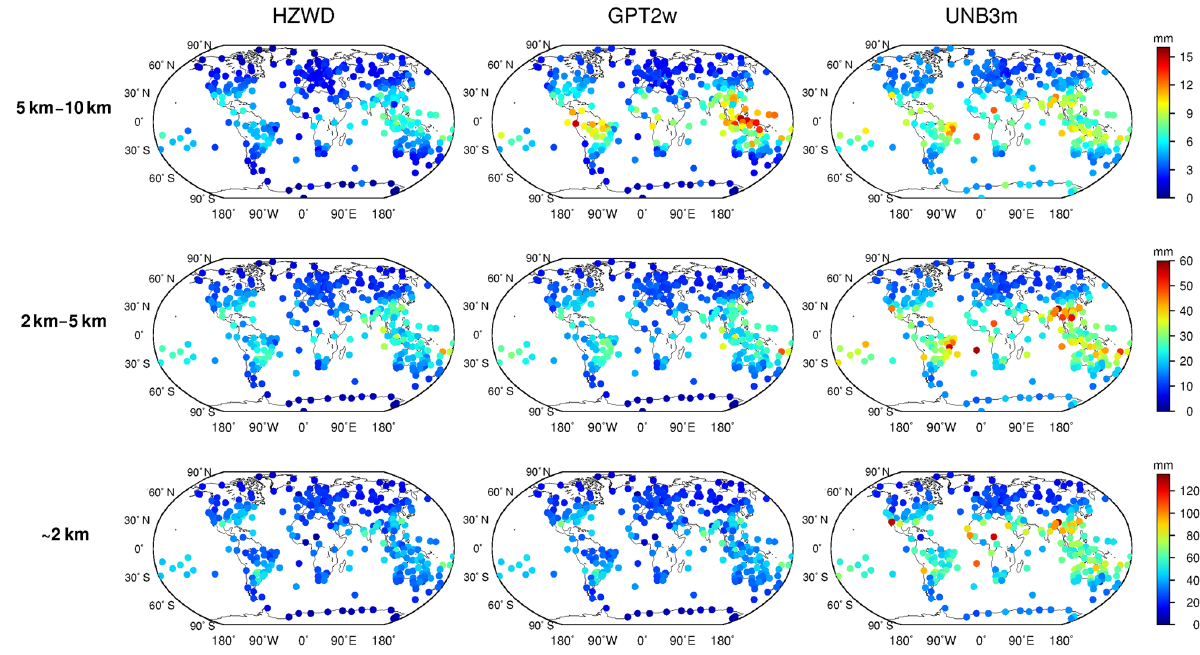
Figure 13. Global distributions of RMSE for the three models (HZWD, GPT2w, and UNB3m) compared to 2015 radiosonde data.